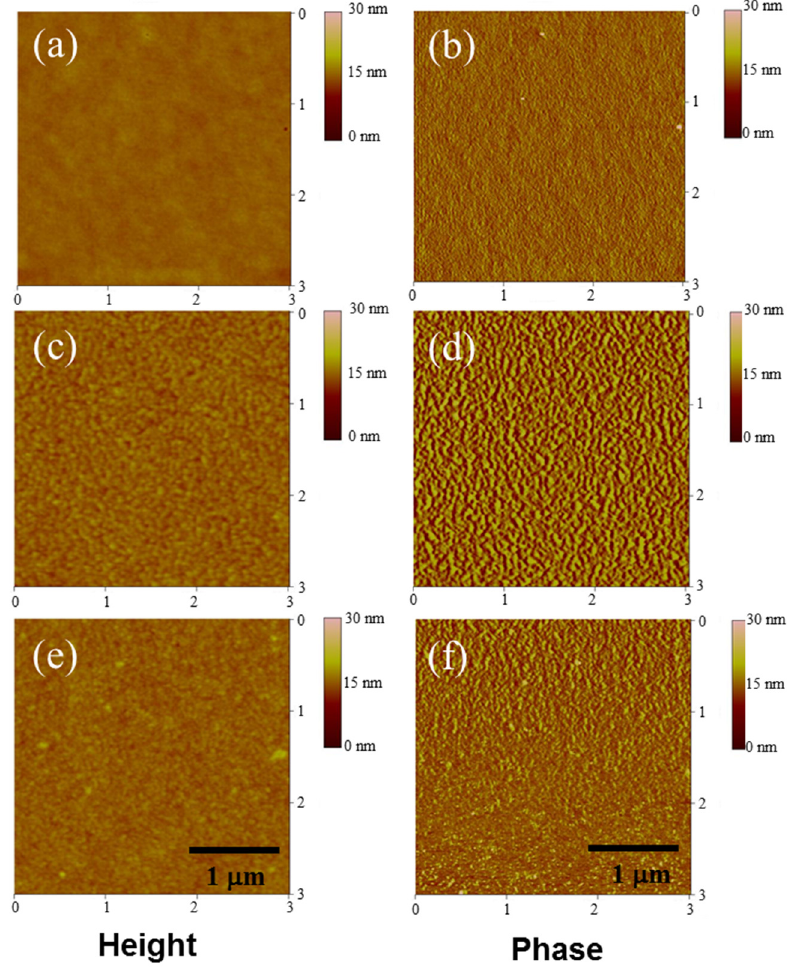
Figure 6. AFM images of the three active layer films in a 3 × 3 µ m scale. Height images ( a , c , e ) and phase images ( b , d , f ) of BTZCZ-2 , PBTZCZ-L , PBTZCZ-H based films.